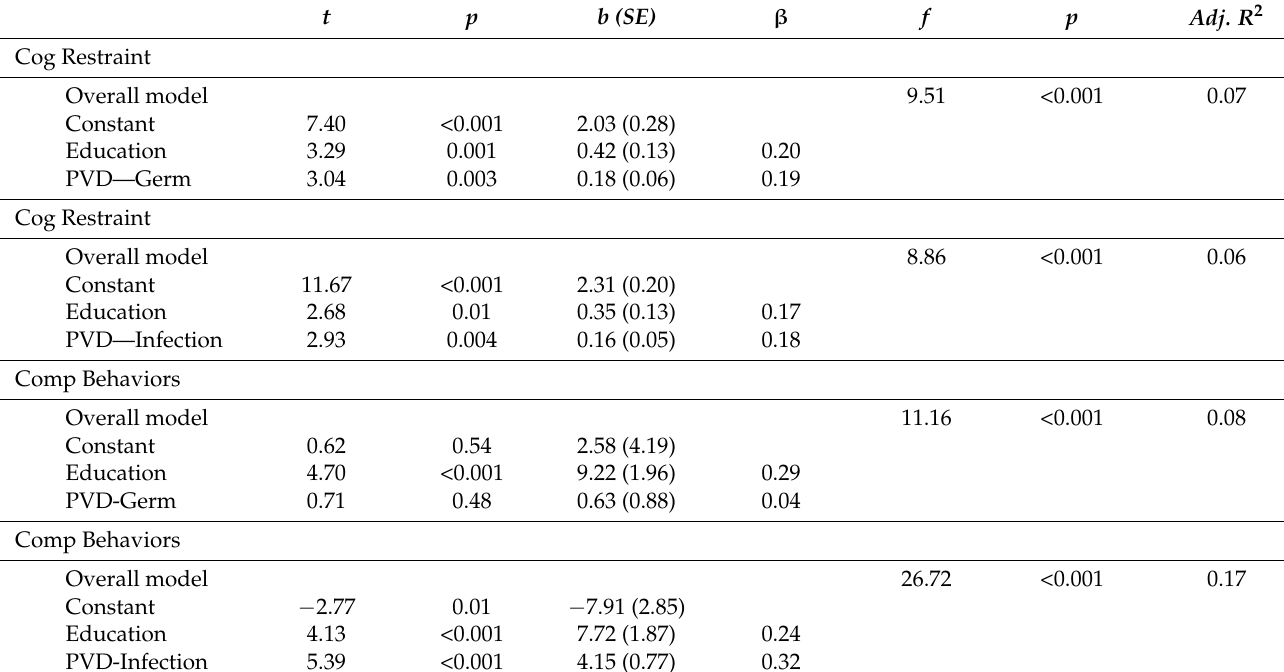
Table A2. Regression analyses for potential covariates.